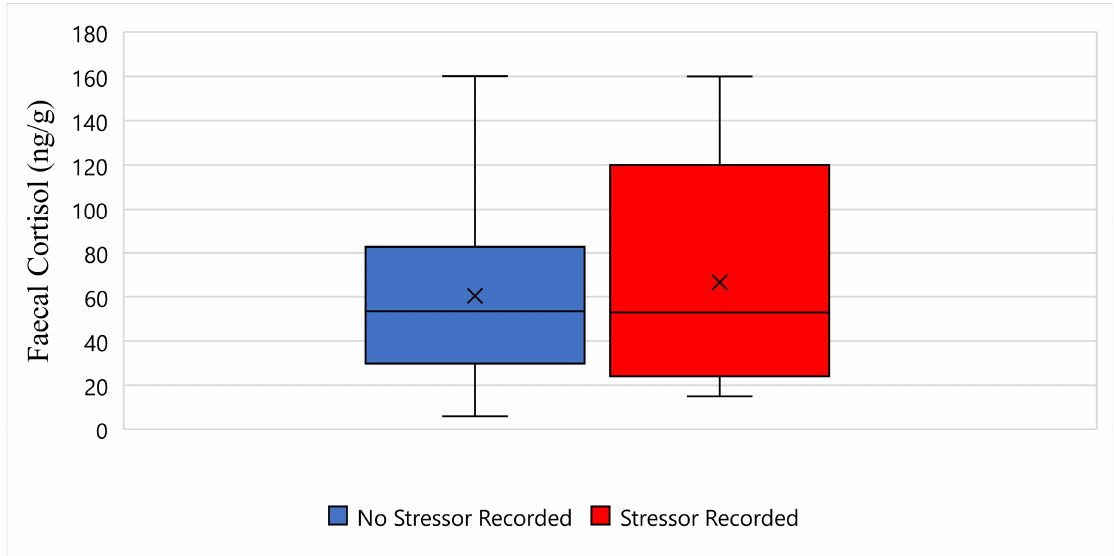
Figure 3. This figure displays the faecal cortisol response for Tai while undergoing wildlife rehabilitation from the start of September 2018 to the end of December 2018 (N = 44, p -Value = 0.915). Days where no stressor was recorded are represented as blue, the days where a stressor was recorded are represented as red, and the cross represents the average faecal cortisol reading for each category.